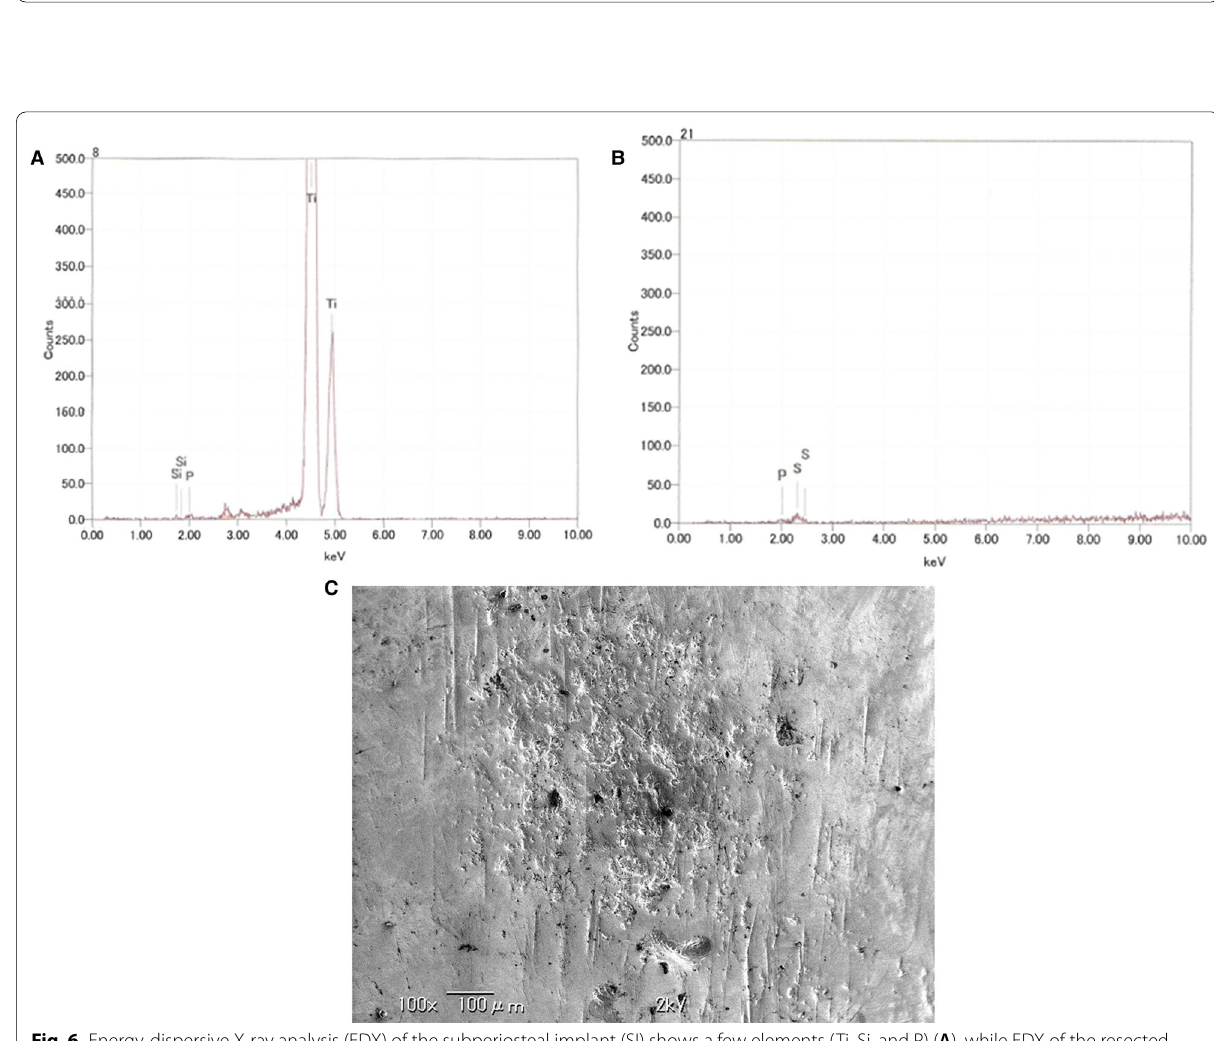
Fig. 5 Subperiosteal implant comprising the metal framework and attachments of the prosthesis; the surface is covered with plaque and calculus ( A , B )